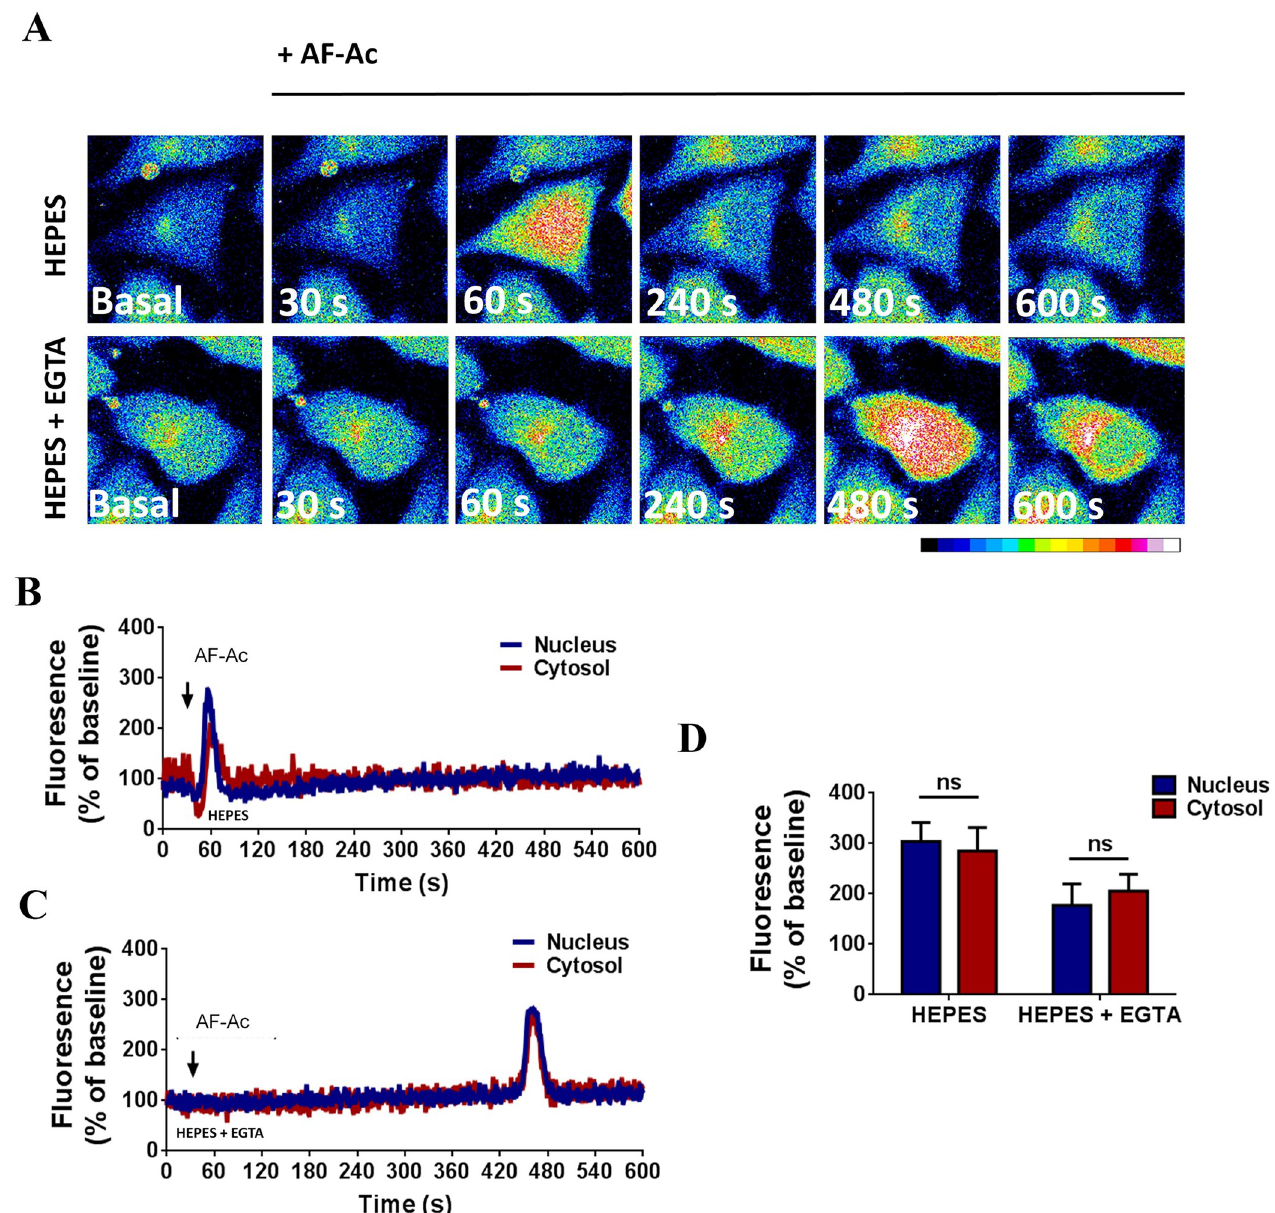
Fig 8. Confocal serial images of HepG2 cells, loaded with fluo-4/AM and stimulated with 50 μ g/mL AF-Ac for 30, 60, 240, 360, 480 and 600 s. Dashed yellow regions represent the nuclear region. Images were pseudocolored according to the scale shown at the bottom. Scale bar = 10 μ M (A). Representative time course of nuclear and cytosol fluorescence levels of HepG2 cells, in the presence (B) or absent (C) of EGTA, stimulated with AF-Ac. Black arrow indicates initial AF-Ac stimulation and fluorescence level is expressed as % of basal fluorescence. Average nuclear and cytosol fluorescence peaks (n = 20 cells) of each cell group and condition throughout the time-course; fluorescence level is expressed as % of basal fluorescence (D). Values are expressed as mean ± SD. ns = p > 0.05 (unpaired